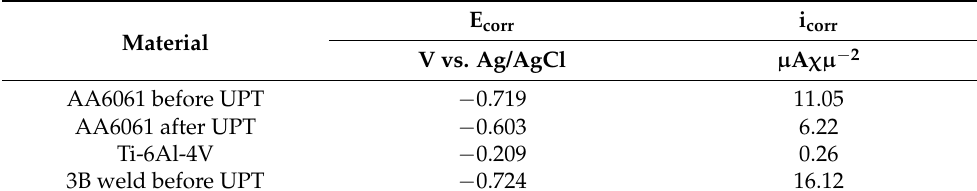
Figure 16. ( a ) Open circuit potential and ( b ) potentiodynamic polarization curves of AA6061 before and after UPT, 3B joint before and after UPT, Ti-6Al-4V samples tested in 3.5% NaCl solution.